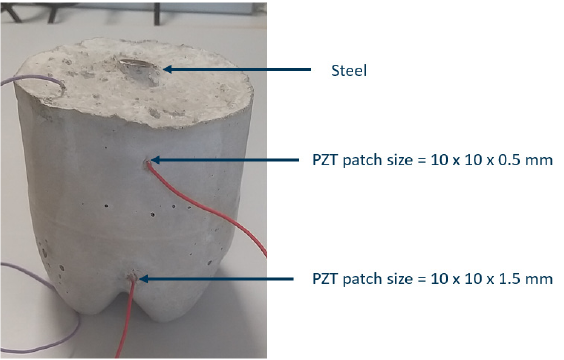
Figure 19. Reinforced concrete with 10 cm long steel rod, used as reference.